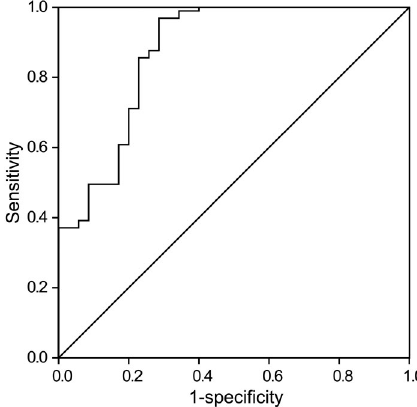
Figure 4. Receiver operating characteristic (ROC) curve of milk fat globule epidermal growth factor 8 (MFG-E8) in diagnosing chronic obstructive pulmonary disease (COPD). The area under the ROC curve was 0.874 (95% con fi dence interval: 0.798 – 0.95; P o 0.01). The MFG-E8 cut-off value in predicting COPD was 5.27 ng/mL (sensitivity 96.9%, speci fi city